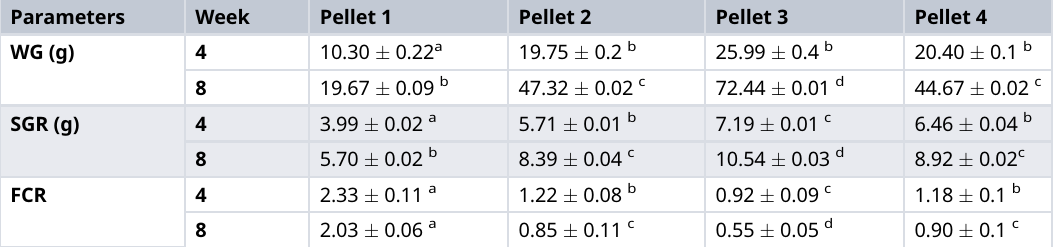
Table 2. Growth performance (WG, SGR, FCR) at Weeks 4 and 8 of Cyprinus carpio treated with Boesenbergia pandurata extract